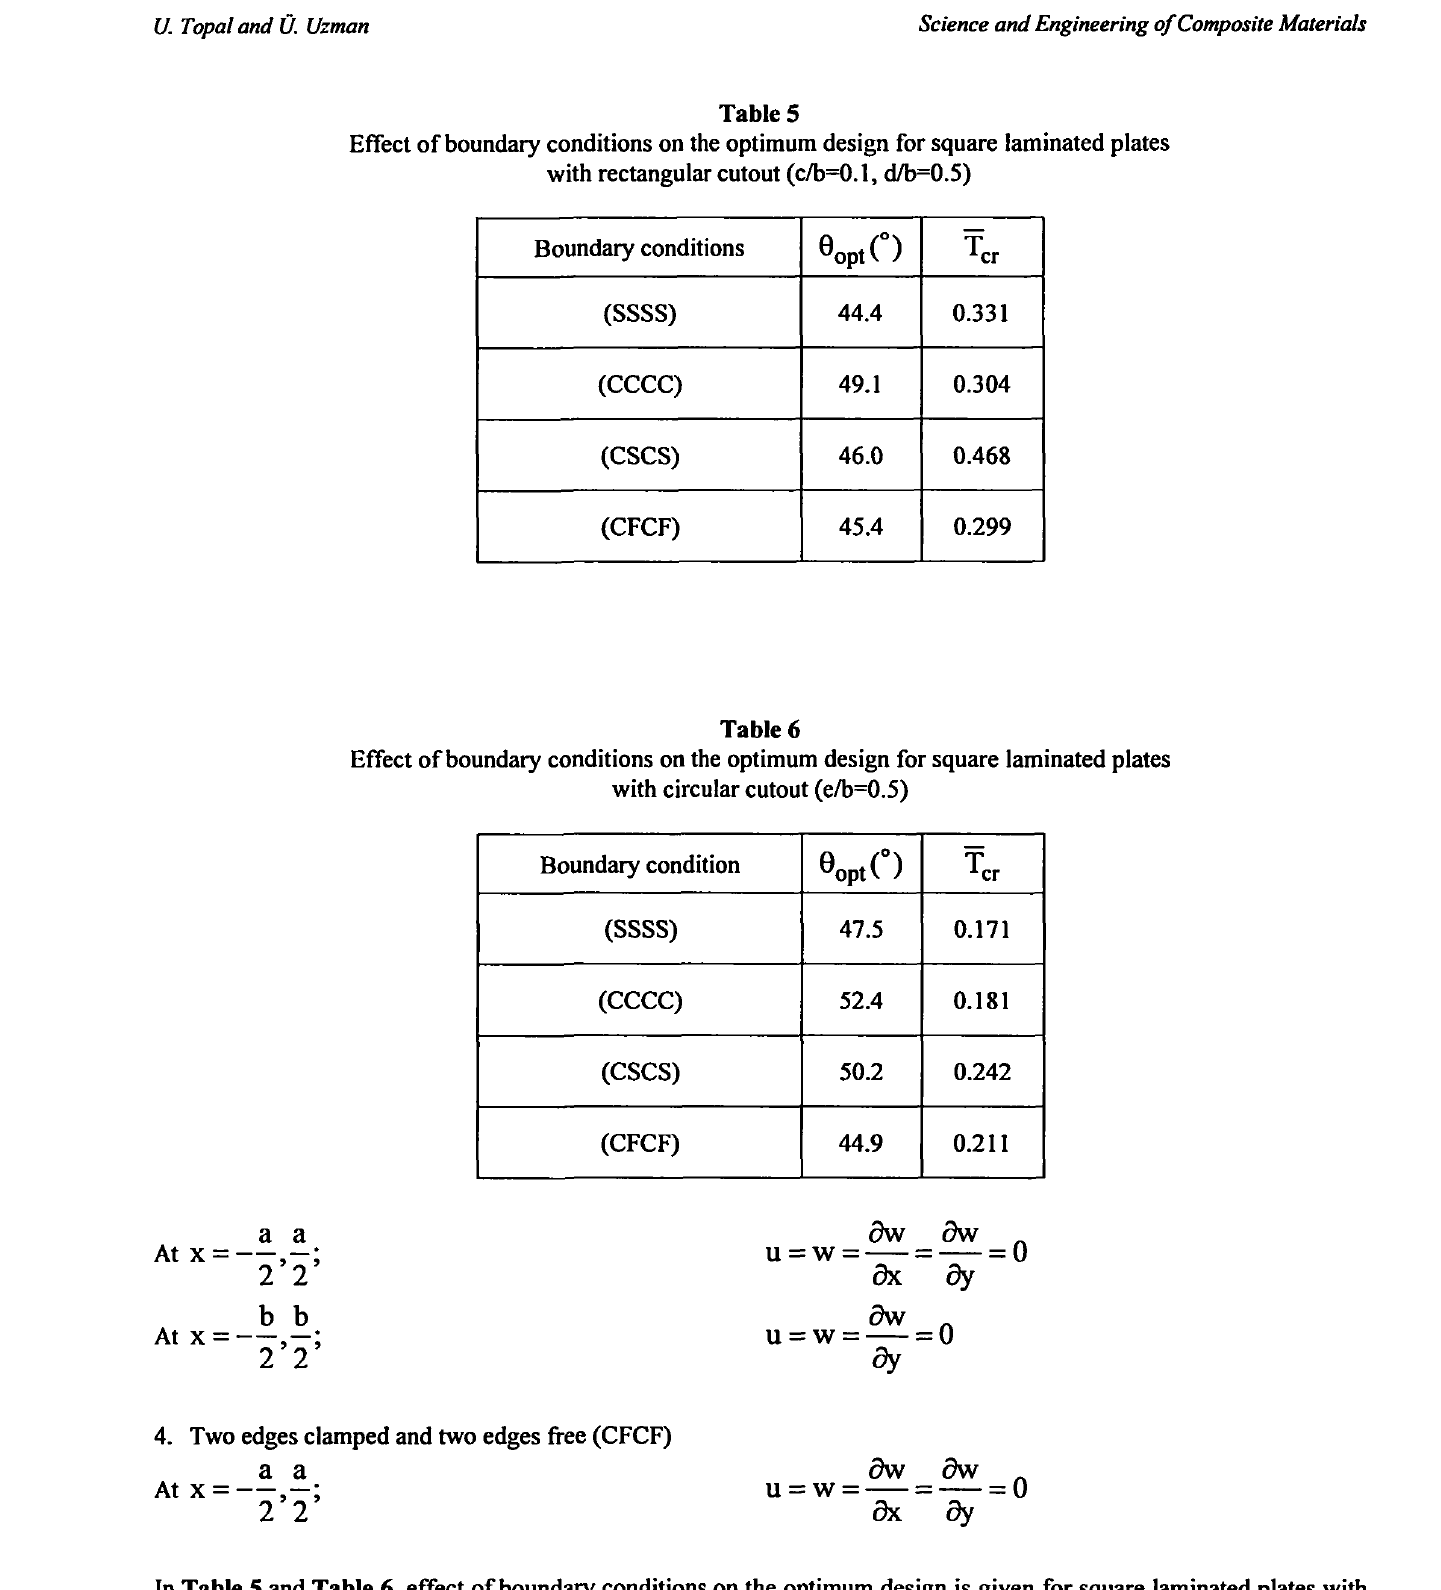
Effect of boundary conditions on the optimum design for square laminated plates with rectangular cutout (c/b=0.1, d/b=0.5)